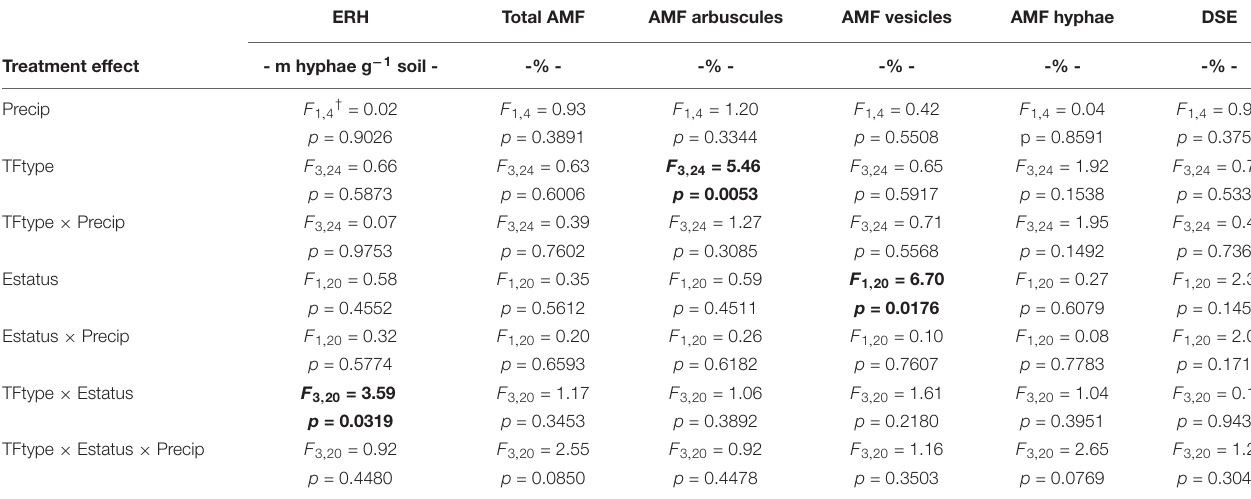
TABLE 1 | Analysis of variance (ANOVA) results for the effects of independent treatment variables on belowground fungal